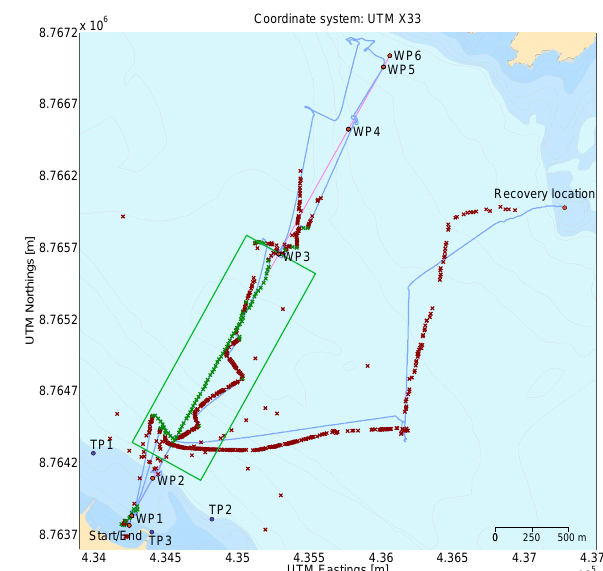
Figure 7: Planned AUV surveys for the campaign. Blue line – Zooplankton survey that was re- peated four times at different times of the day (transect A-B). Pink line – Cross-fjord survey (WP 1-6).